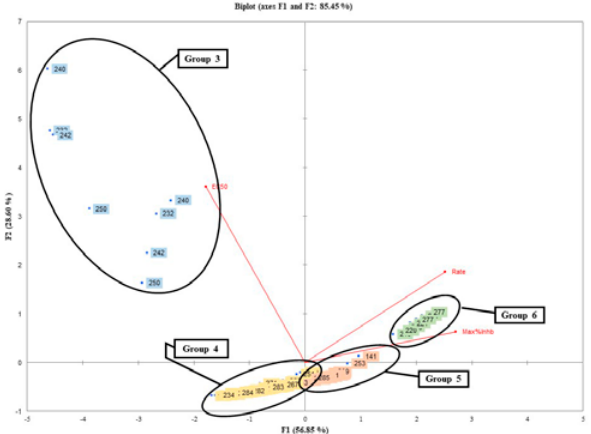
Figure 1. Principal component analysis (PCA) indicating separa- tion of Phytophthora nicotianae and Phytopthora citrophthora iso- lates into four distinct mefenoxam sensitivity groups based on the regression parameters EC 50 , rate of inhibition and